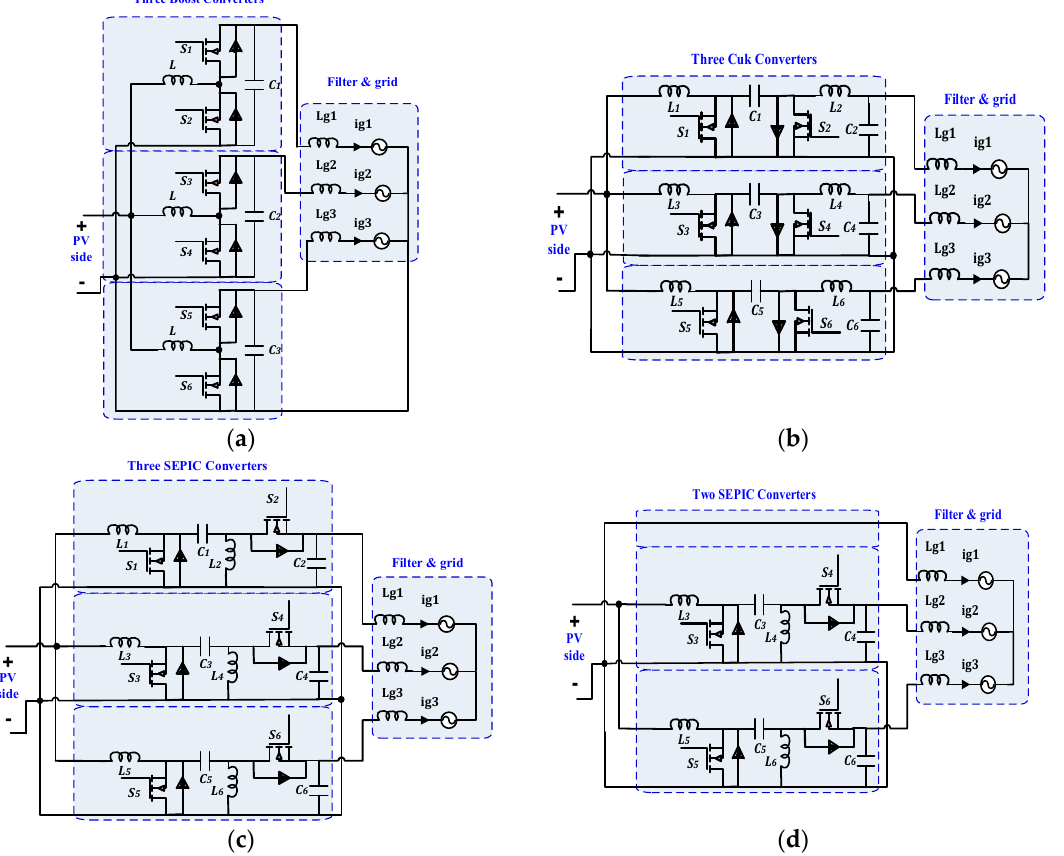
Figure 8. Non-isolated differential three-phase microinverter topologies: ( a ) differential boost inverter [83]; ( b ) differential Cuk inverter [84]; ( c ) differential SEPIC inverter [85]; ( d ) differential based four-switch SEPIC [86].